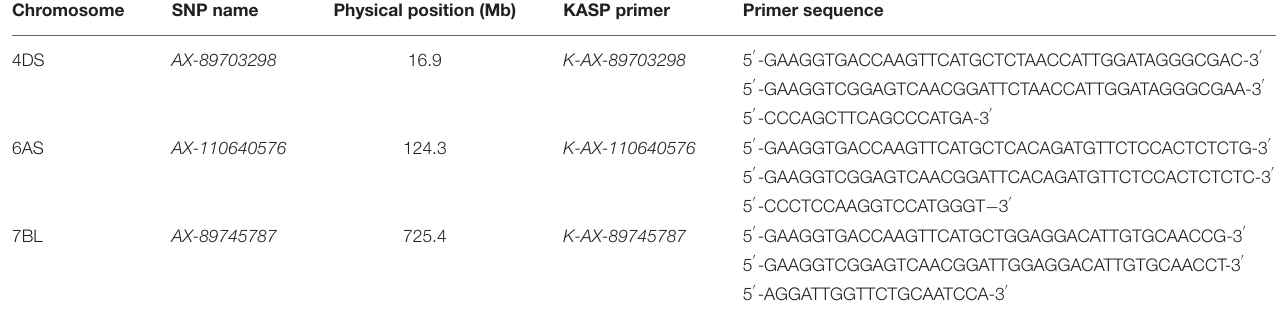
TABLE 6 | Kompetitive allele specific PCR (KASP) markers converted from single-nucleotide polymorphisms (SNPs) tightly linked to identified QTL on three chromosomes. Chromosome